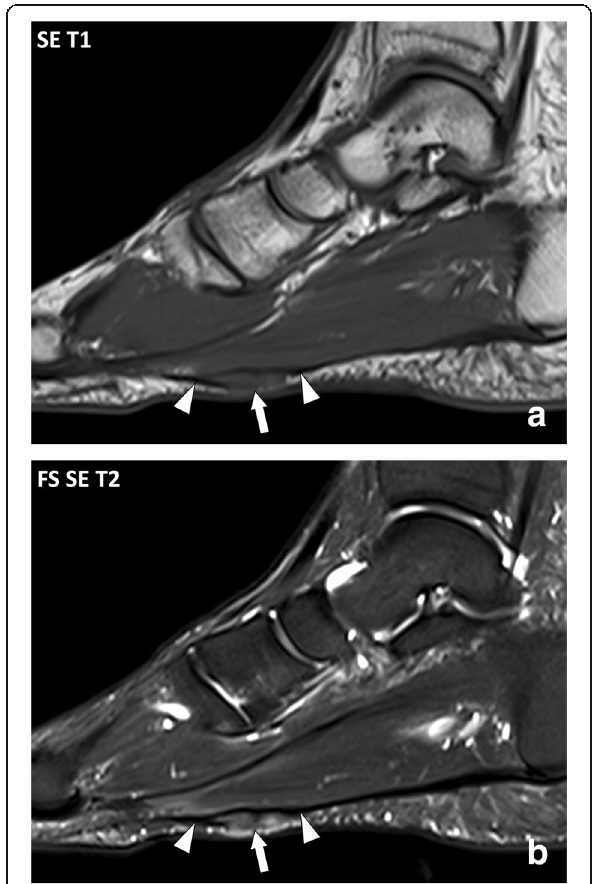
Fig. 12 Axial SE T1w images of the hands of a 48-year-old male with palmar fibromatosis. a Palmar aponeuroses are normal in their proximal parts with thin regular margins (black arrowheads). b MRI demonstrates low signal intensity nodules (arrows) in continuity with the palmar aponeuroses (white arrowheads) located in front of the flexor crease of the fourth and fifth fingers corresponding to fibromatosis